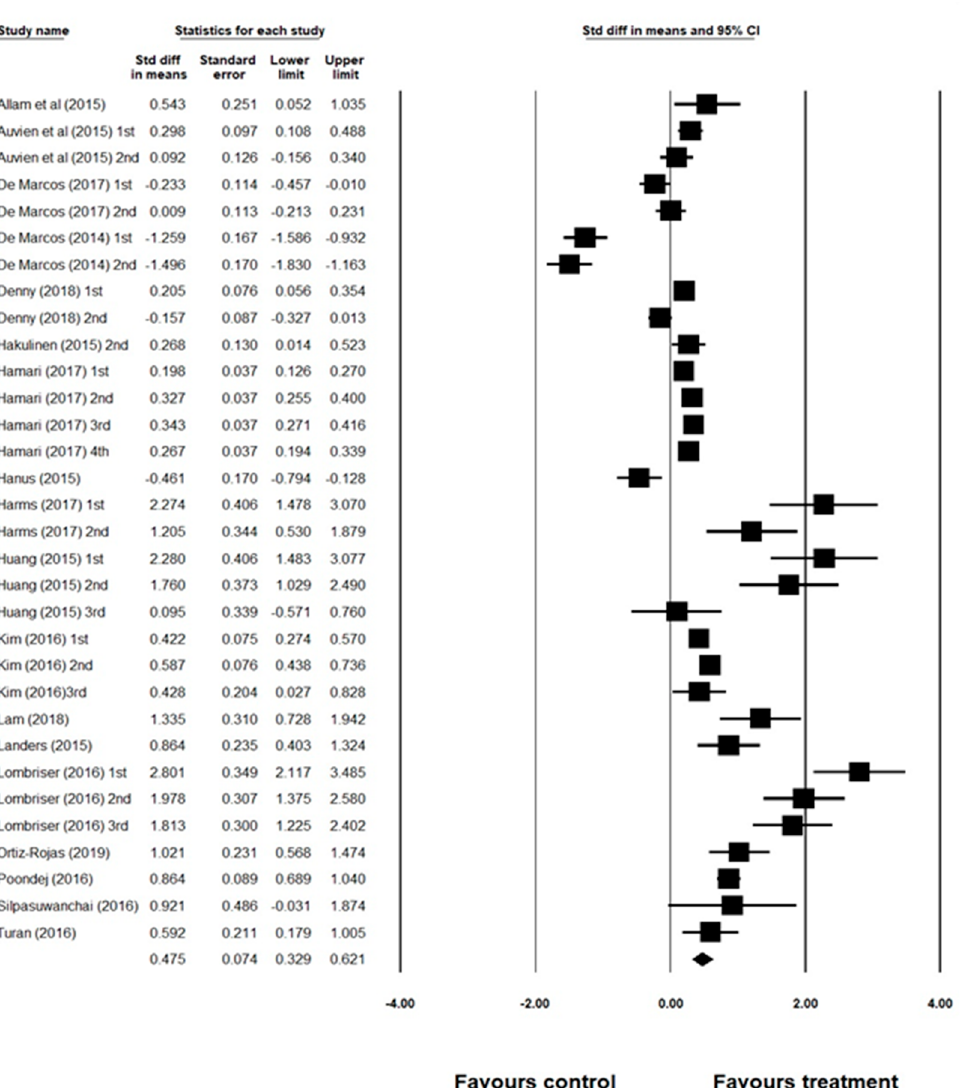
Figure 2. Standardized mean difference effect sizes, 95% CI and a forest plot. Table 2. Effect sizes by moderator variables in the meta-analysis .